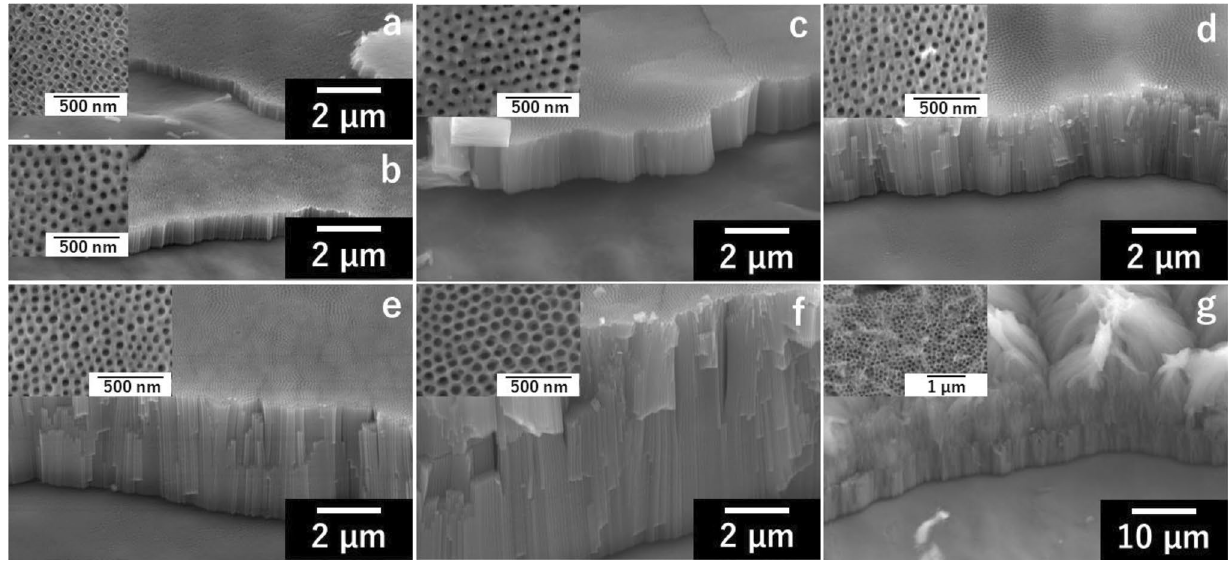
Figure 1. SEM images of TNTAs prepared by different anodization conditions: the voltage of 30 V was applied for ( a ) 1 min, ( b ) 3 min, ( c ) 5 min, ( d ) 15 min, ( e ) 30 min and ( f ) 60 min in an electrolyte with DMSO, and ( g ) 60 V for 60 min was applied in an electrolyte without DMSO.